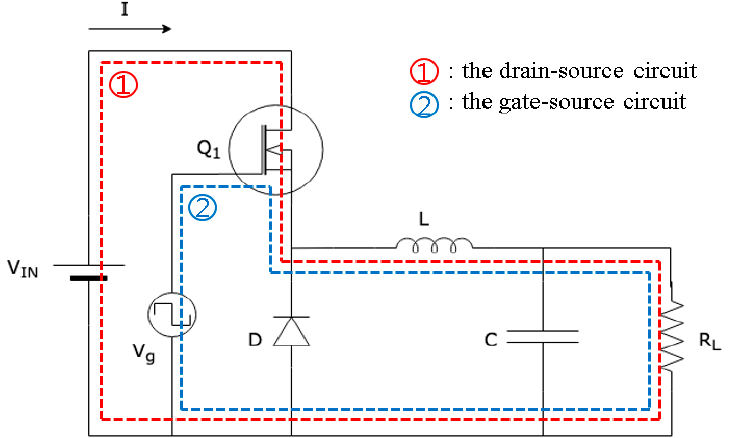
Figure 4. The concept of circuit separation to divide into two parts.